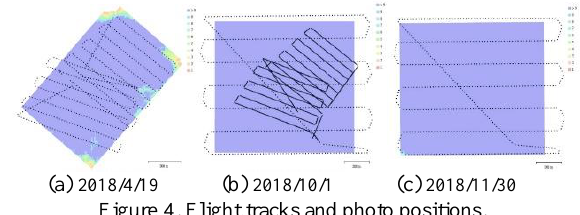
Figure 4. Flight tracks and photo positions.